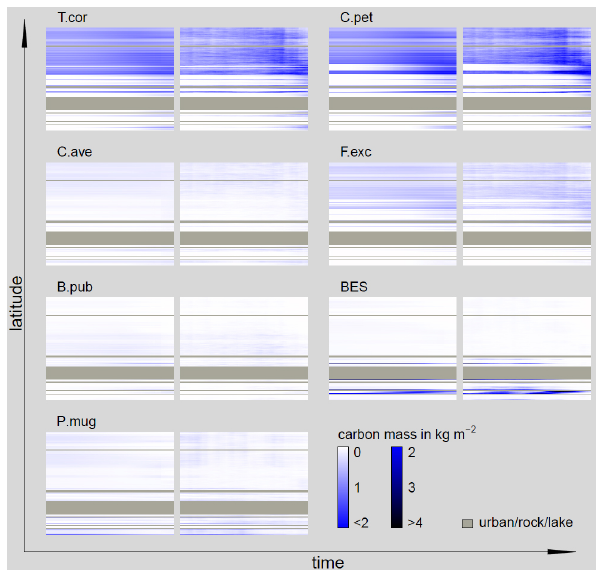
Figure D8. Carbon mass development of the minor species along the analyzed transect using the stochastic (100 stochastic replicates) LPJ- GUESS approach (right) and the GAPPARD method (left), both with the adjusted parameter set. The timescale in each plot extends from 1900 (left side) to 2100 (right side). See Fig. D3 for species abbreviations. Please note that a different color gradient was used than in Fig.